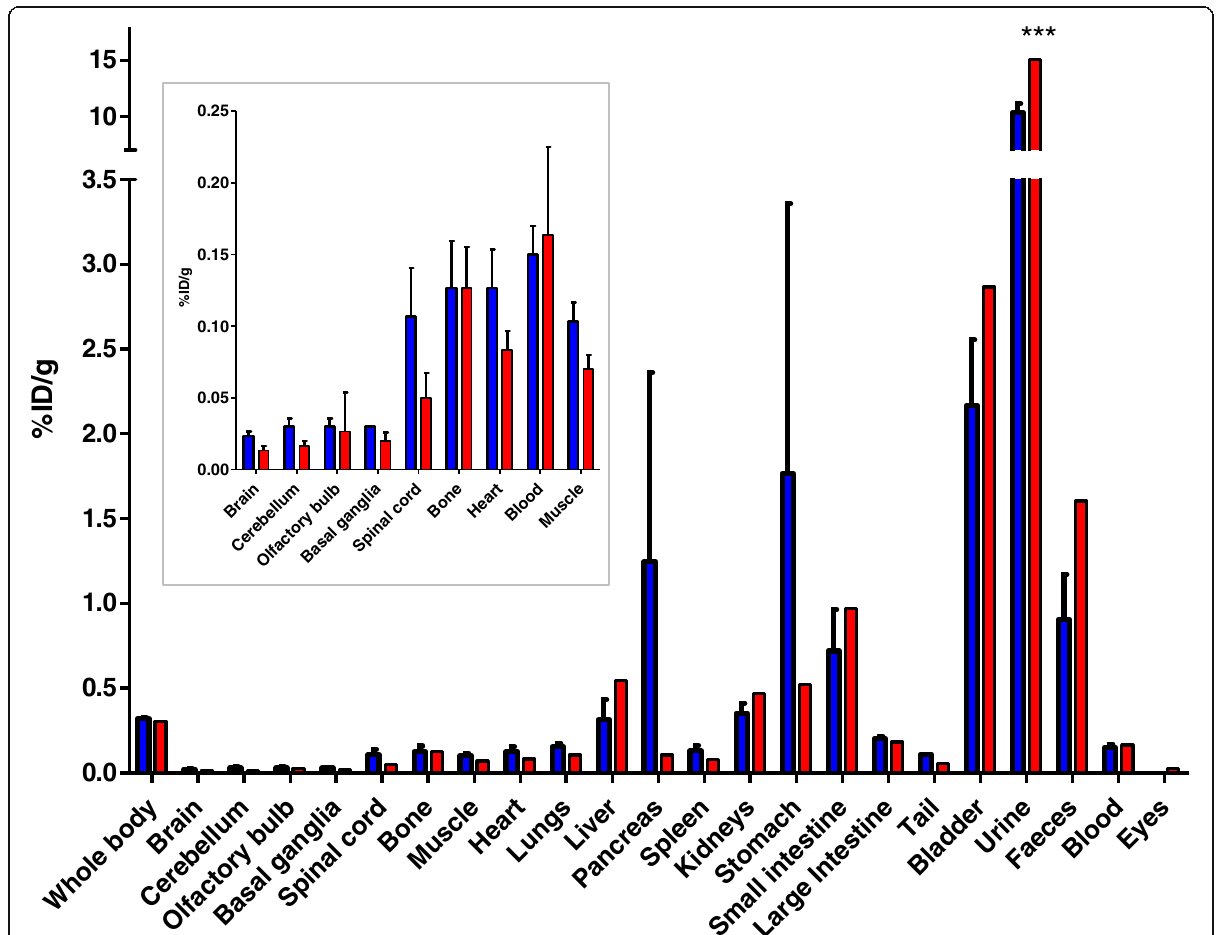
Fig. 9 Biodistribution of [ 18 F]EFB at 90 min post-injection in LPS ( blue bars ) vs. control ( red bars ) rats. The insert is a blow-up of some regions of interest with low tracer